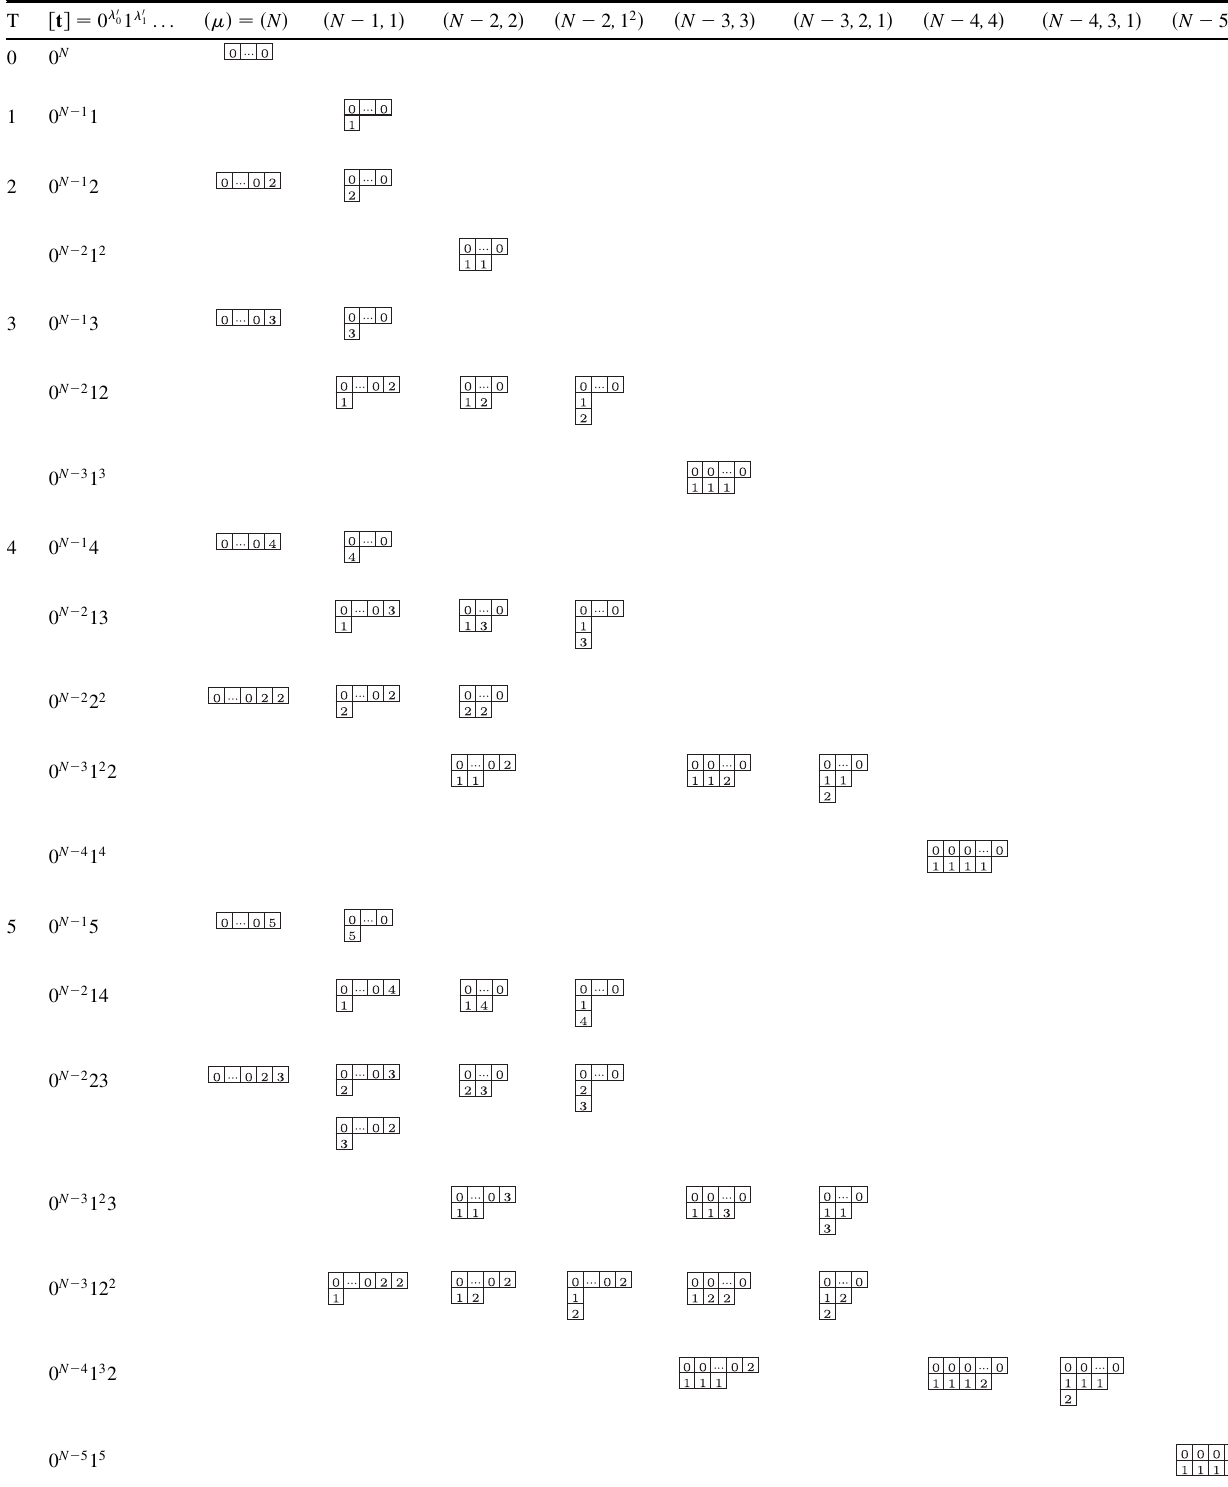
TABLE III. Irreducible subspaces for difference modes with total excitation number T (cid:13) 5 . In this Table, the equivalence class ½ t (cid:4) with (cid:9) 0 f pseudomodes with exactly f excitations is denoted 0 (cid:9) 0 0 1 (cid:9) 0 1 (cid:11) (cid:11) (cid:11) , where all entries with (cid:9) 0 f ¼ 0 are suppressed. All semistandard tableaux of shape ð (cid:6) Þ and content ½ t (cid:4) are listed in the corresponding row and